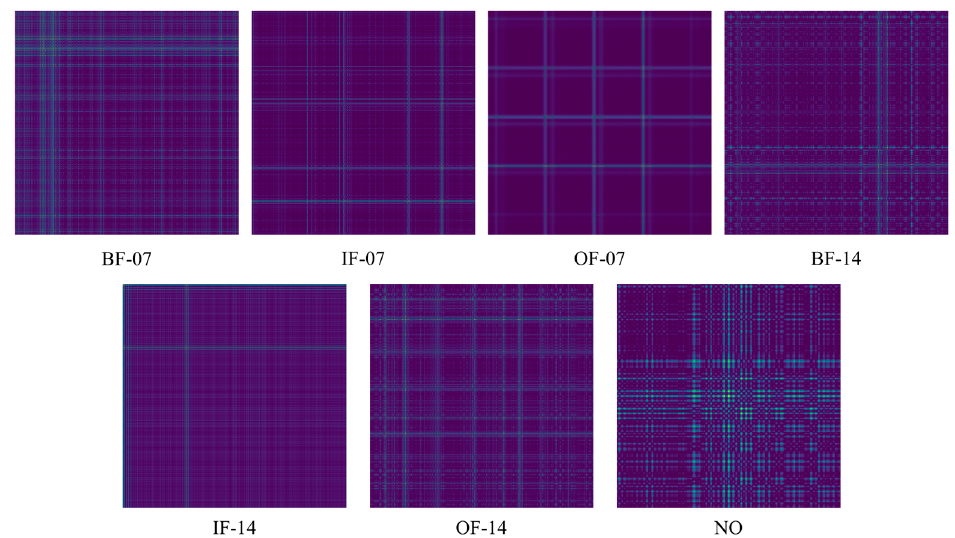
Figure 9. Converted images in this work.